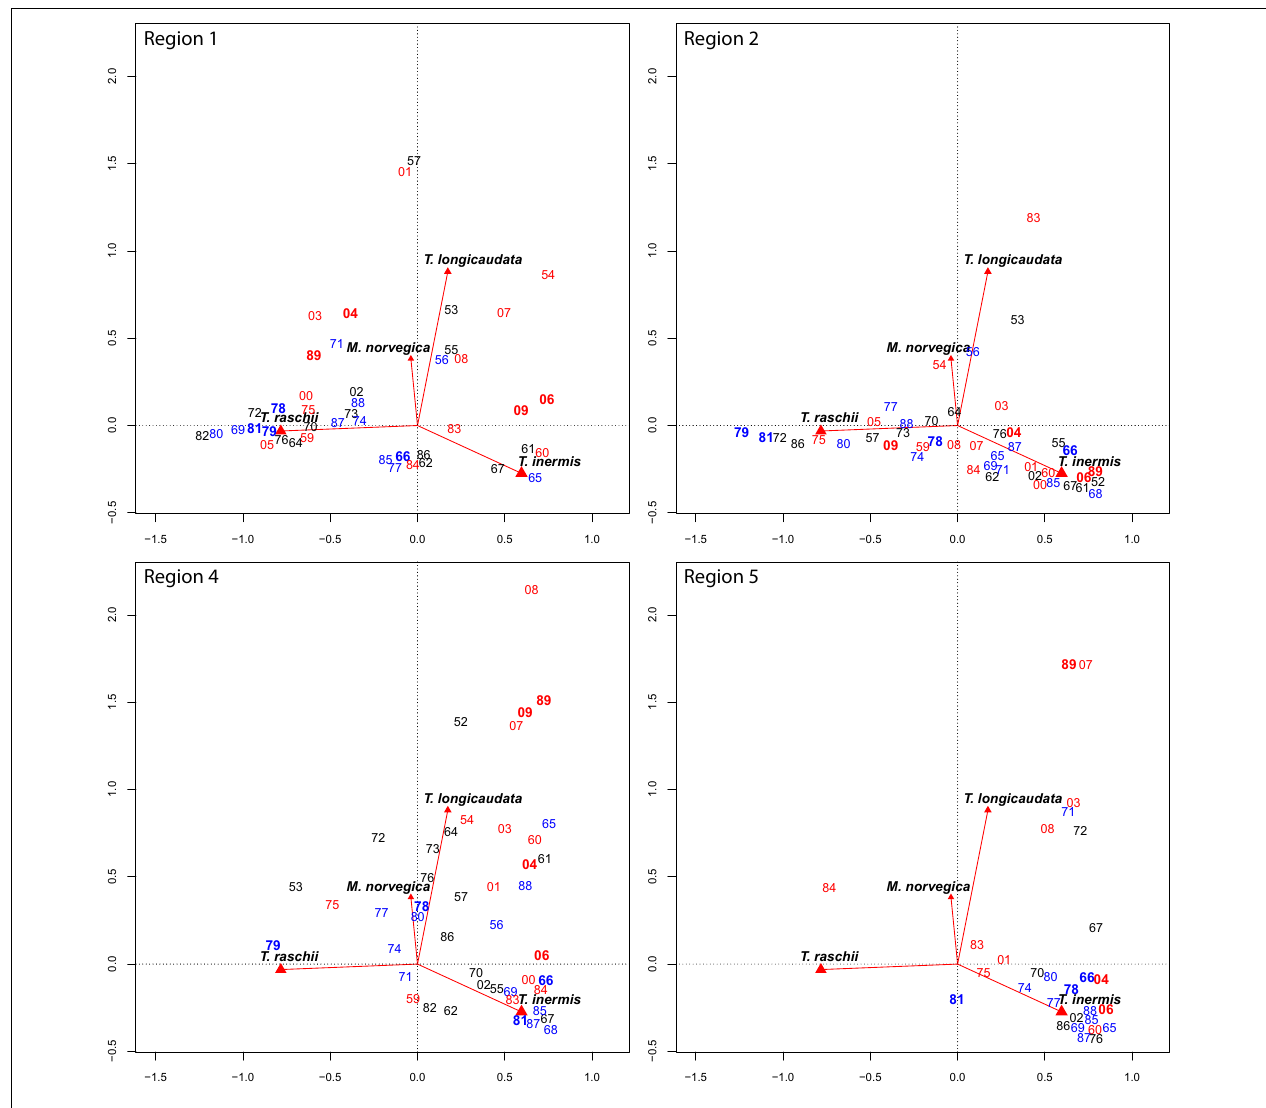
FIGURE 4 | Sampling years (labeled by last two numerals) for each of Regions 1, 2, 4, and 5 superimposed on the CA biplot for the entire data series. Years in dark bold red are very warm years, years in red are warm, years in black are normal, light blue